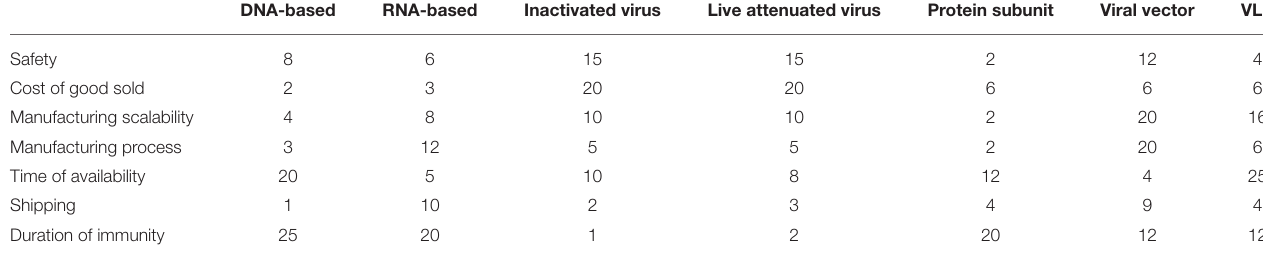
TABLE 1 | Risk score of the different categories of risk for each vaccine technology. DNA-based RNA-based Inactivated virus Live attenuated virus Protein subunit Viral vector